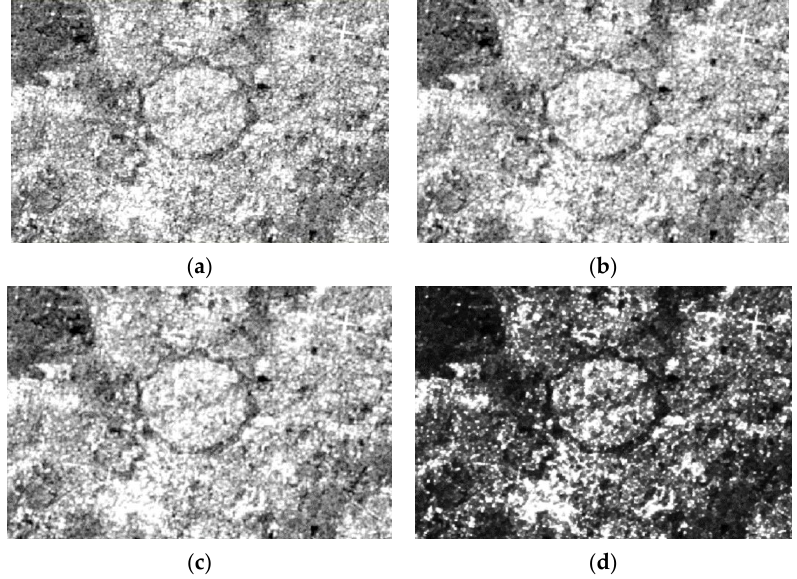
Figure 4. Speckle filtering comparison: ( a ) Lee Sigma; ( b ) Lee; ( c ) Frost; ( d ) Refined Lee.